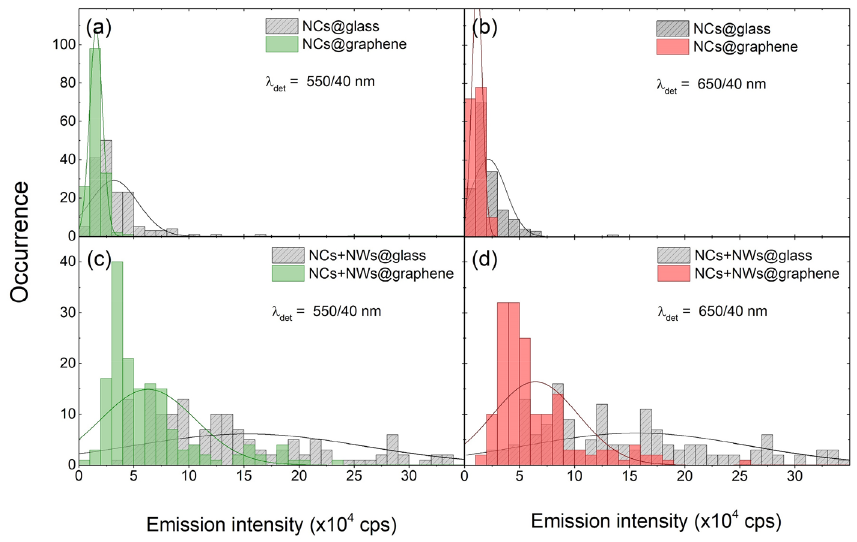
Figure 4. Histograms of photoluminescence intensity of ( a , b ) nanocrystals and ( c , d ) nanocrystals combined with silver nanowires, deposited on glass and graphene. Green ( a , c ) and red ( b , d ) emission of Er 3+ is shown. Each histogram was obtained for approximately 150 individual